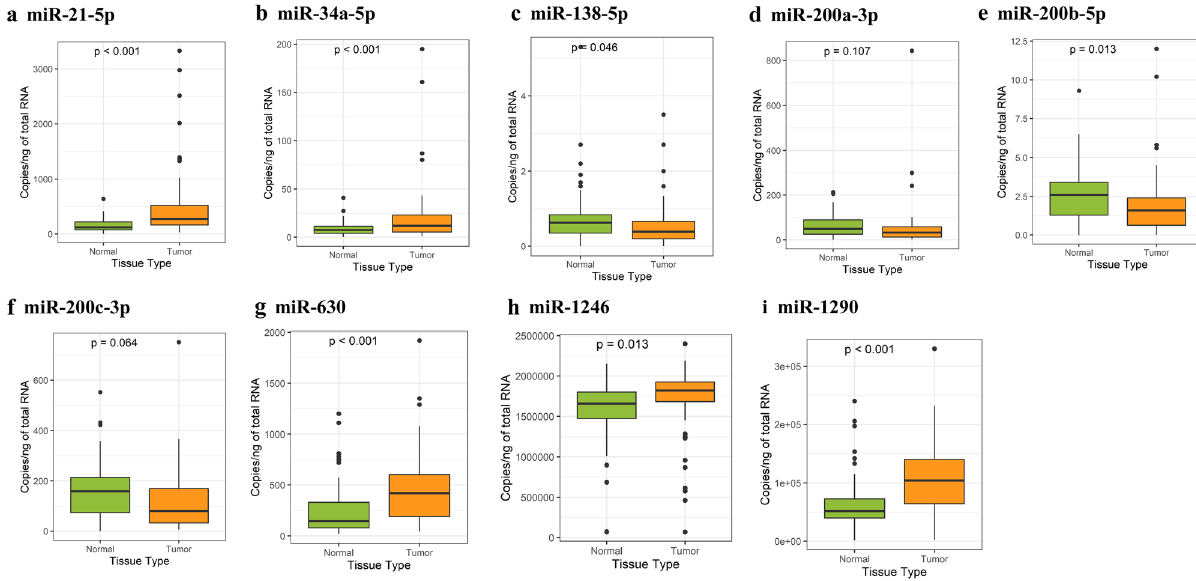
Figure 1. miRNA expression levels in tumor and normal tissues from CRC patients. Tumor tissues had high expression of miR-21-5p, 34a-5p, 630, 1246, and 1290 compared to normal tissues ( a , b , g – i ). The expression levels of miR-138-5p, 200a-3p, 200b-5p, and 200c-3p were lower in tumor tissues than in normal tissues ( c – f ).